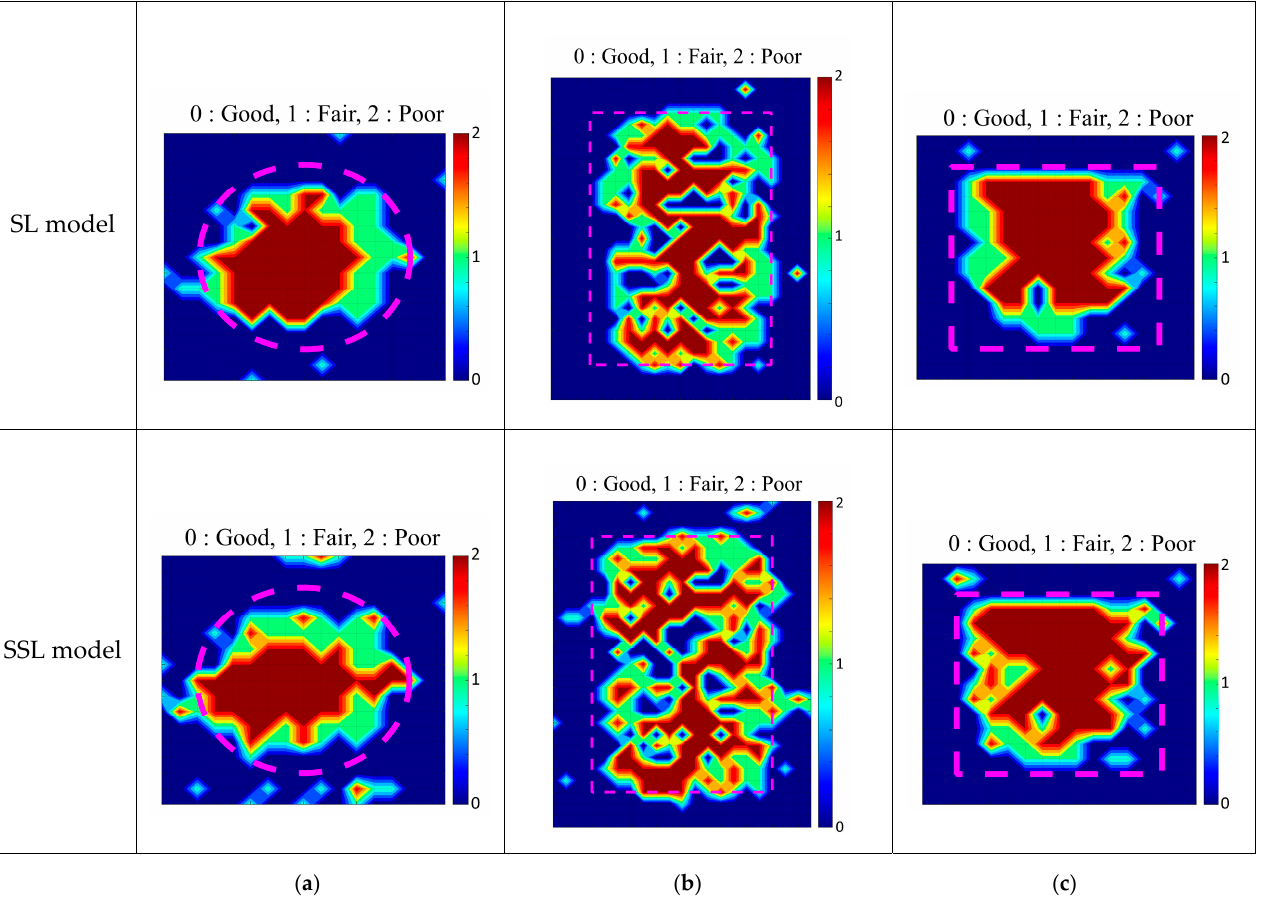
Figure 12. First performance verification of the SL and SSL models: ( a ) DL-A2, ( b ) DL-A4, ( c ) DL-A5.